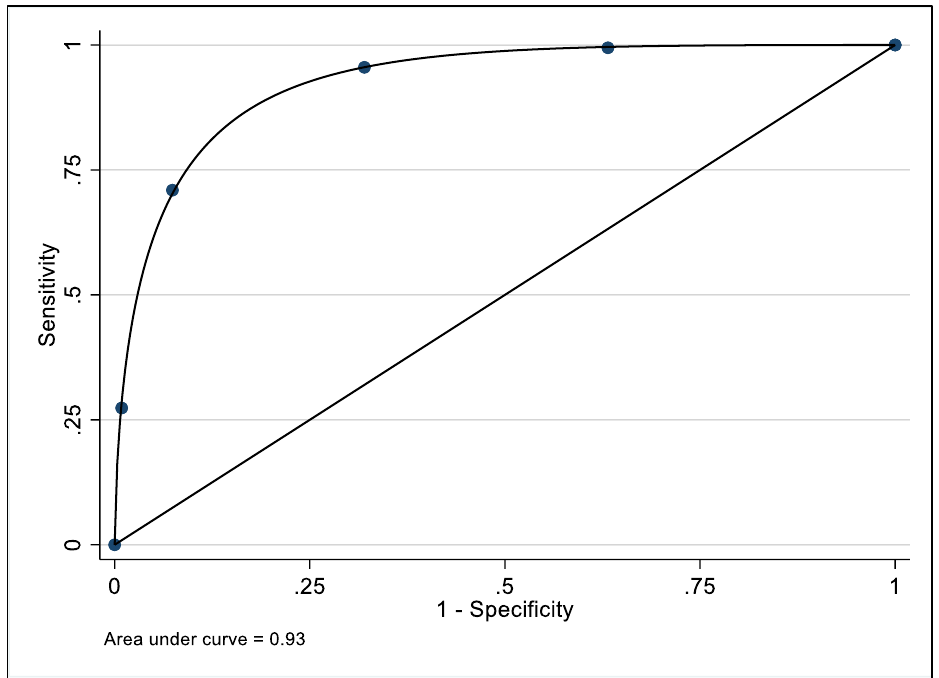
Figure 3. Receiver operating characteristic curve for the TTPN single item measure of mental distress against established K6 measure of psychological distress. Table 2. Measures of correspondence between the binary measure of distress from the K6 and the TTPN distress